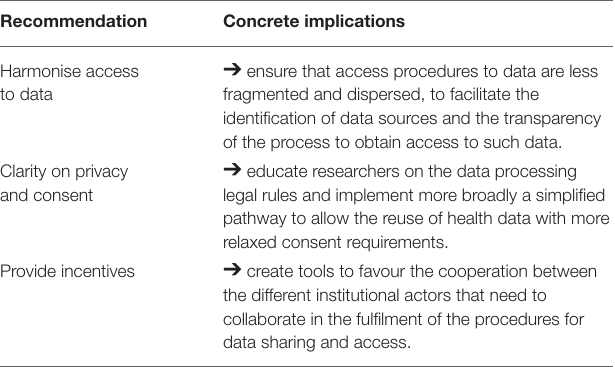
TABLE 3 | Recommendations concerning processes and procedures. Recommendation Concrete